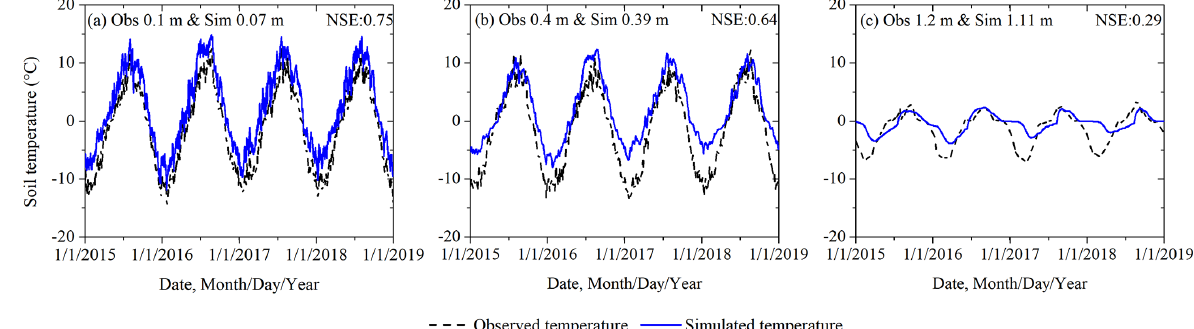
Figure A2. Validation of simulation results at different depths at QT08 against the observed daily soil temperatures during 1 January 2015 to 31 December 2018 for (a) a simulation depth of 0.07m and observation depth of 0.1m; (b) 0.39m for simulation and 0.4m for observations; and (c) 1.11m for simulation and 1.2m for